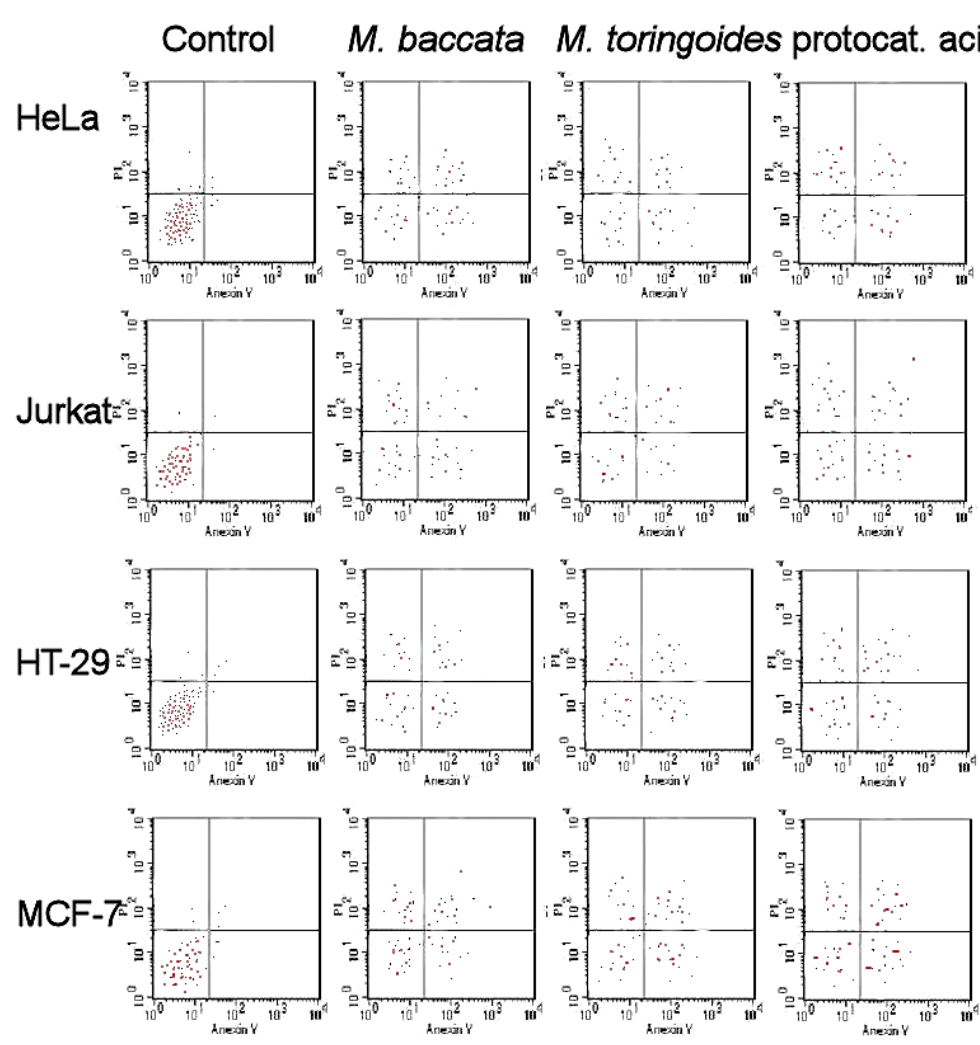
Figure 3. Flow cytometry of bark extracts after 48 h. Necrotic cell accumulation was found in the early and late apoptotic phases using IC 50 concentration of bark extracts and protocatechuic acid. Protocat. acid: protocatechuic acid.